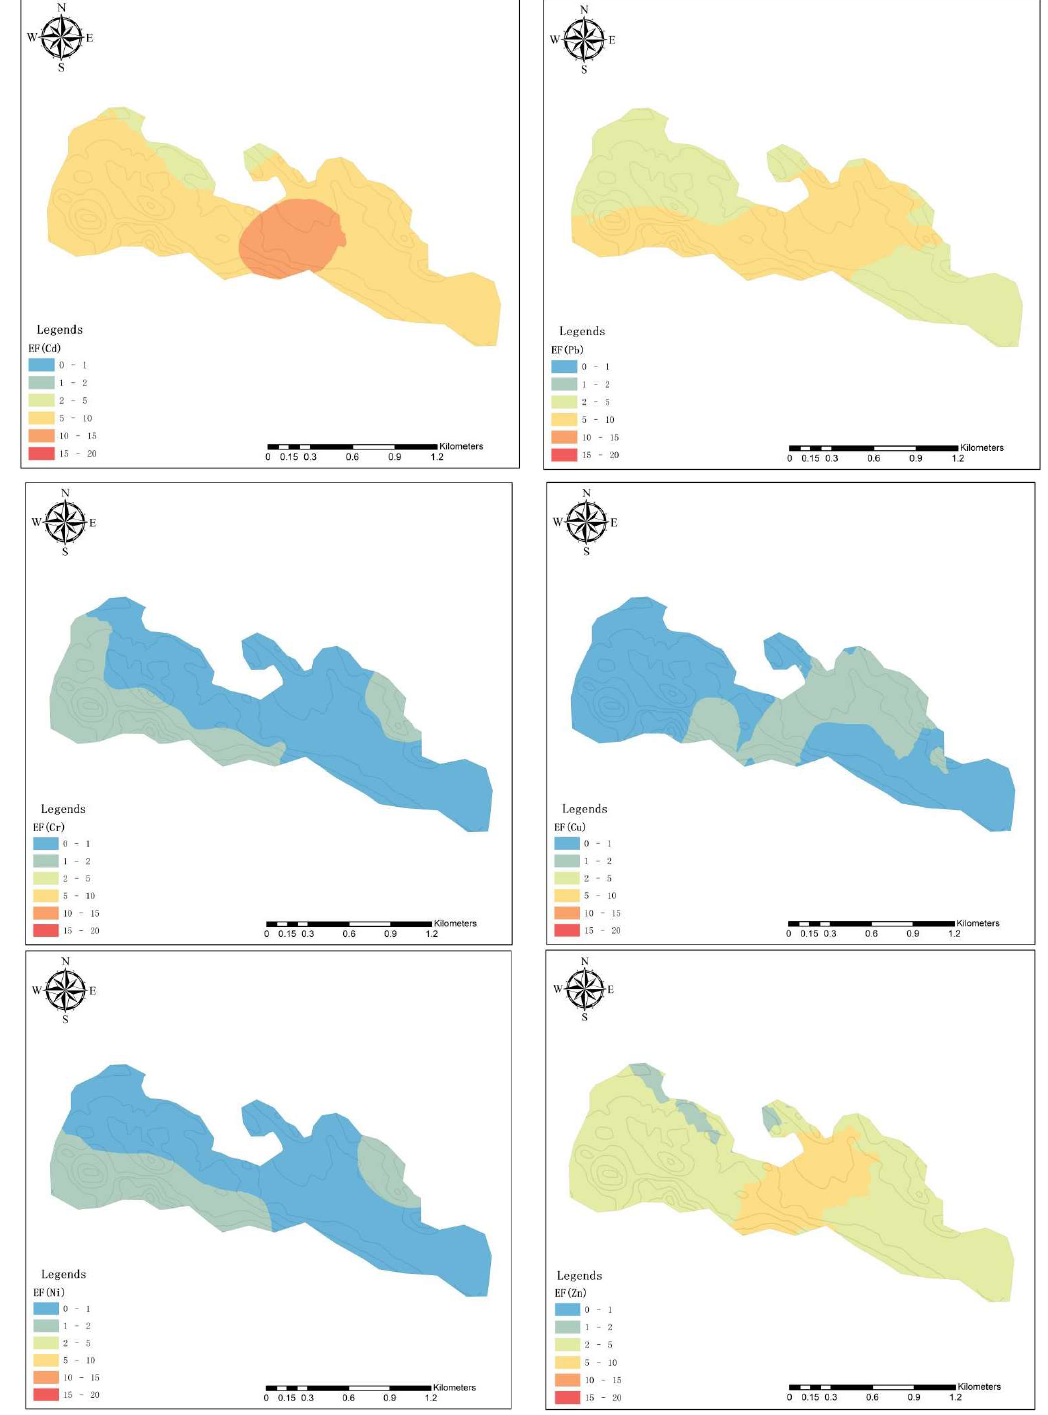
Figure 5. Distribution of enrichment factor (EF) of Cd, Pb, Cr, Cu, Ni and Zn in topsoil. 2. Soil profiles